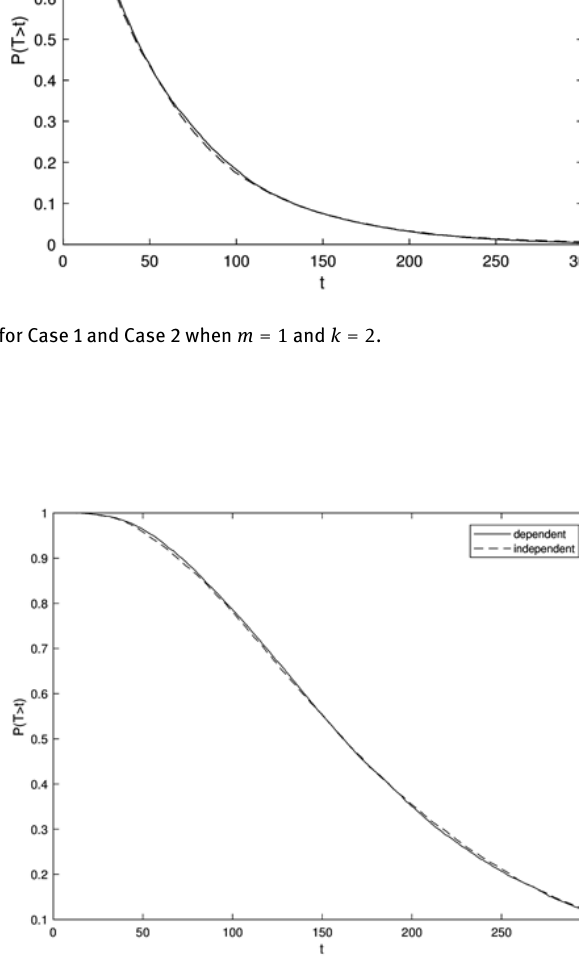
Figure 2: Survival functions for Case 1 and Case 2 when m = 3 and k = 2